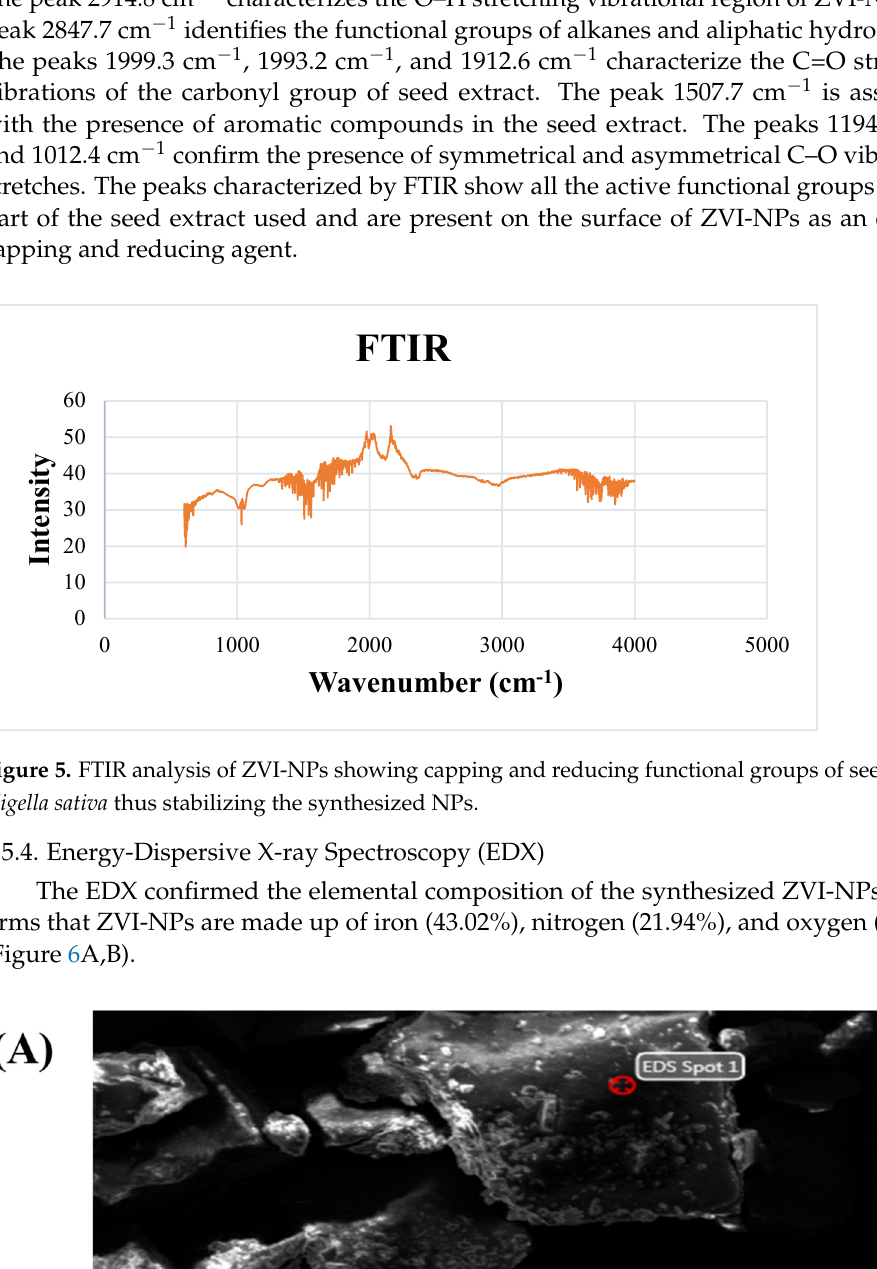
Figure 4 . Scanning electron micrograph of ZVI - NPs synthesized by seed extract of Nigella sativa at concentration of 25 mM of FeCl 3 . ( A ). at 1000X ( B ). at 500X.